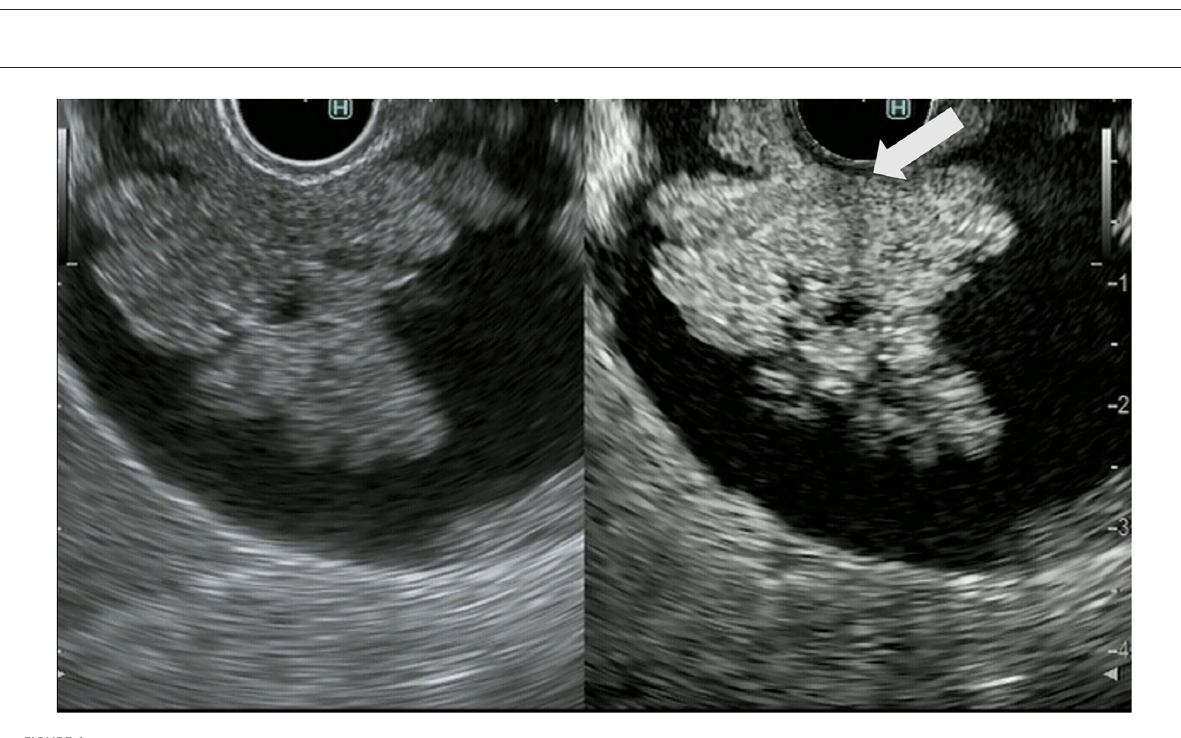
FIGURE4 Contrast-enhanced harmonic endoscopic ultrasound (EUS) for gallbladder polypoid lesions. Gallbladder adenocarcinoma: The polypoid lesion has a perfusion defect area